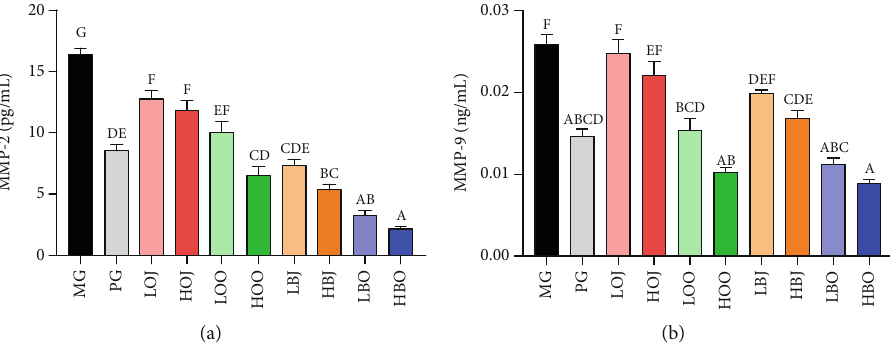
Figure 5: E ff ect of di ff erent treatments on the level of serum MMP-2 and MMP-9 in the golden hamster: (a) MMP-2 level and (b) MMP-9 level. Values are expressed as the mean ± SD ( n = 8 ). Signi fi cance was de fi ned as P < 0 : 05 .